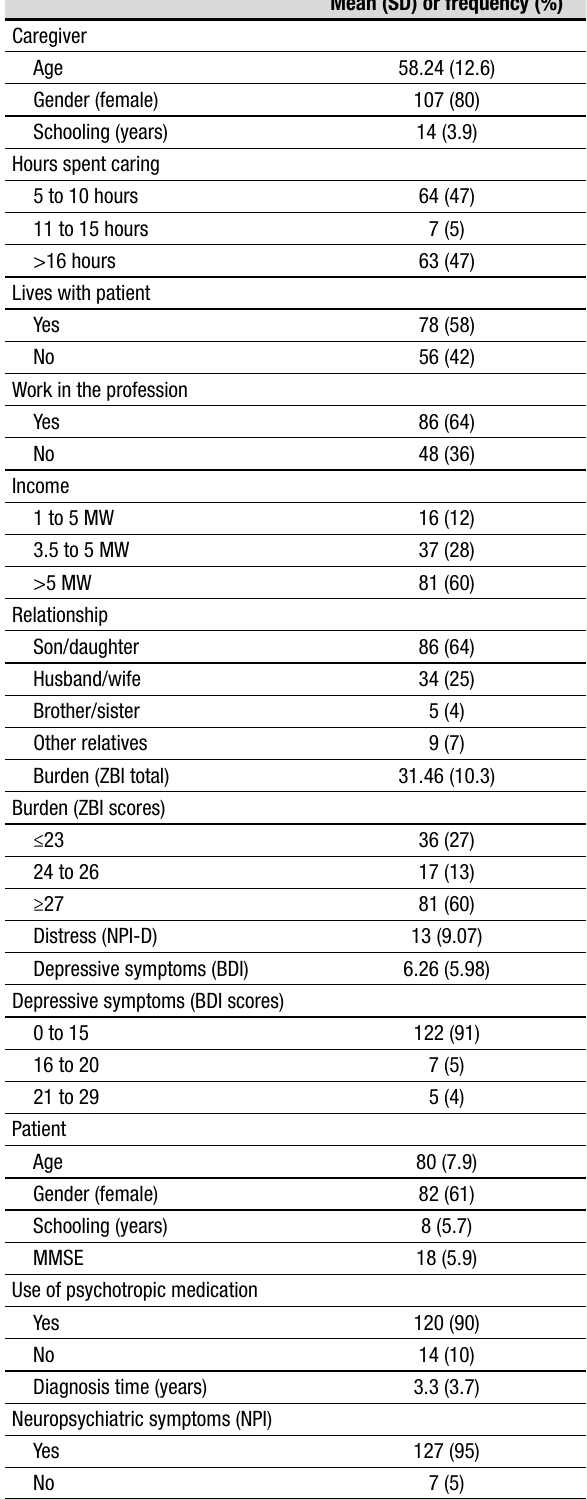
Table 1. Characterization of the sample of caregivers and people with Alzheimer’s disease according to the variables investigated.